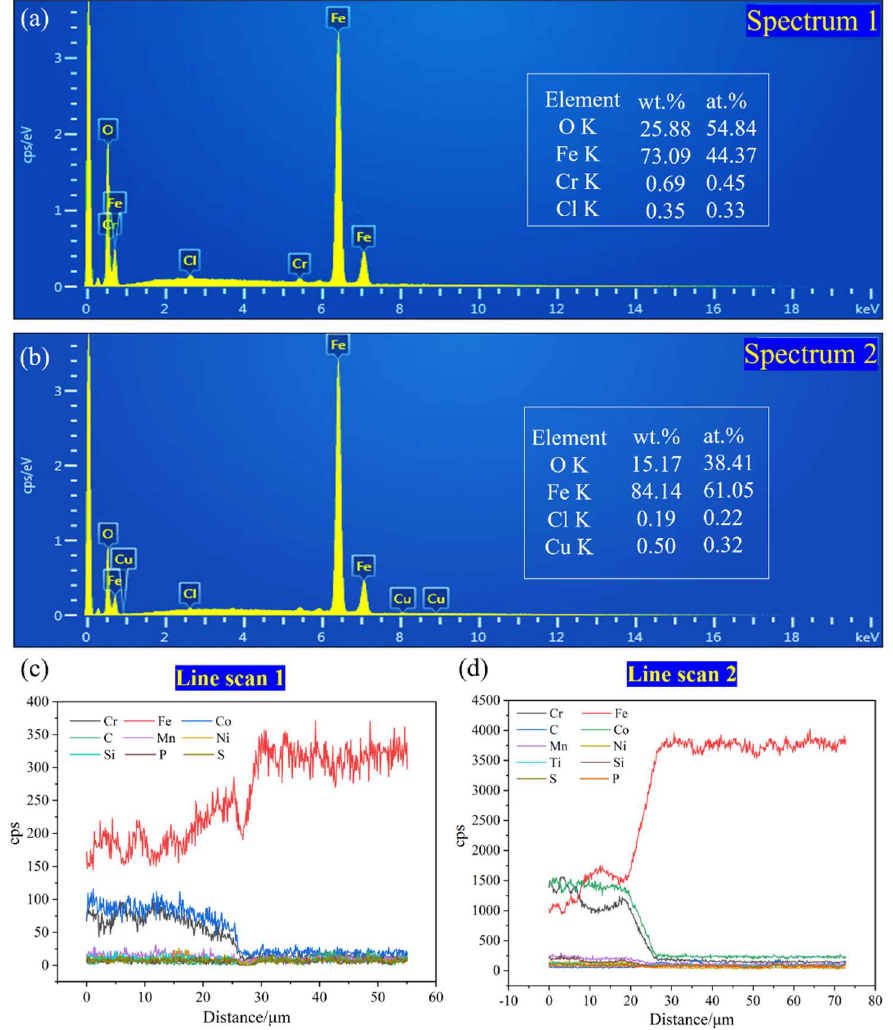
Figure 5. ( a ) Dot scanning spectrum of the Ti 0 coating, ( b ) dot scan spectrum of the Ti 0.5 coating, ( c ) line sweep spectrum of the Ti 0 coating, ( d ) line sweep spectrum of the Ti 0.75 coating. Table 2. Chemical composition of dendrite and interdendrite (at.%).